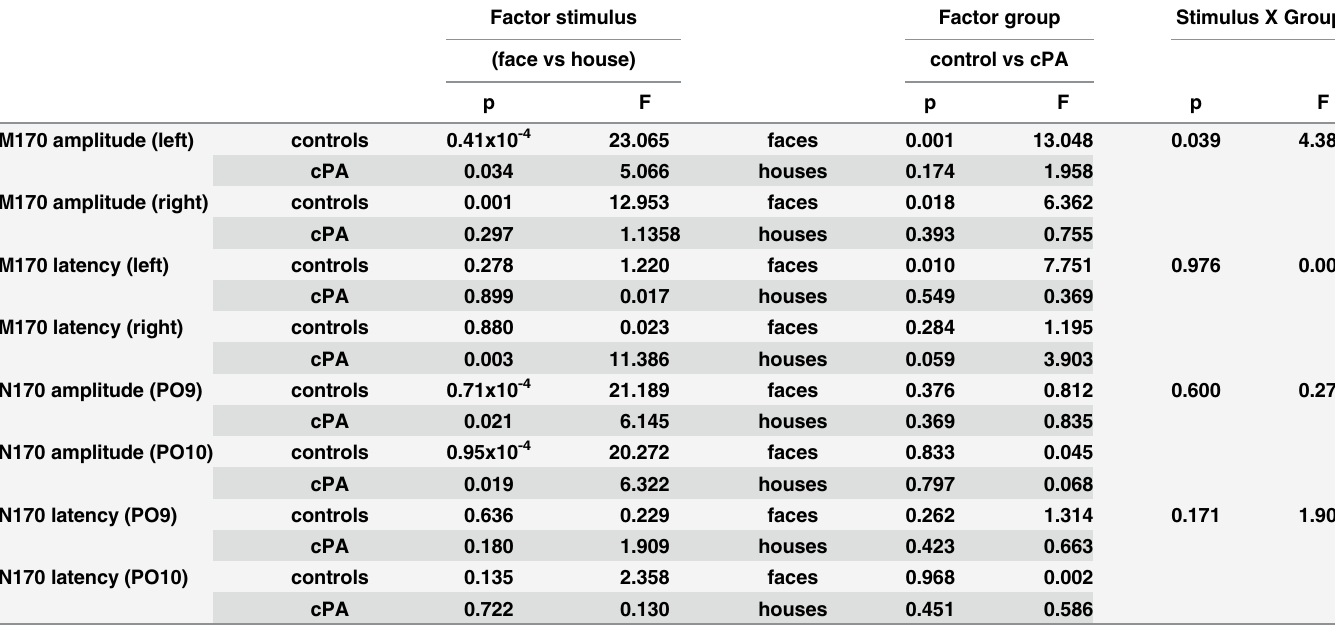
Table 2. Detailed results from the mixed ANCOVA are shown for experiment 1; MEG: upper half; EEG: lower